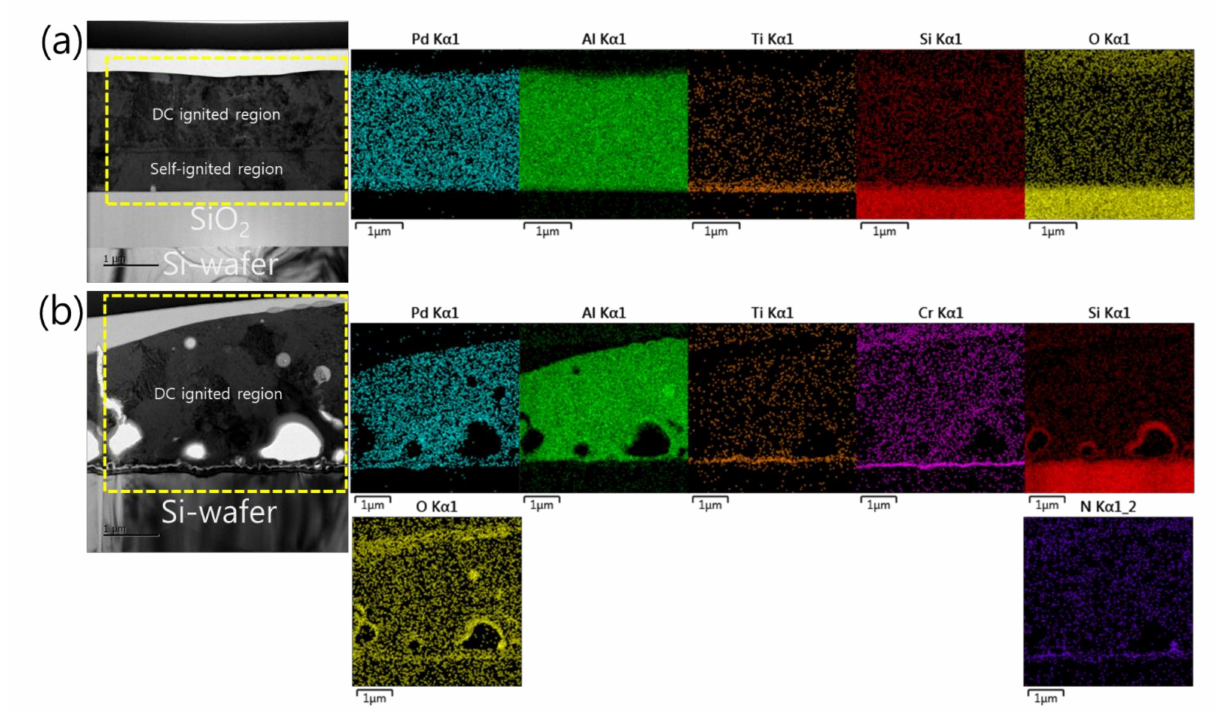
Figure 7. TEM cross sections ( left ) and corresponding EDS elemental mappings ( right ) of the Pd/Al-iRMS reaction product microstructure after the exothermic propagation reaction. ( a ) Pd/Al-iRMS with a bilayer thickness of δ = 100 nm grown on a SiO 2 -coated Si-wafer; ( b ) Pd/Al-iRMS with a bilayer thickness of δ = 200 nm grown on a PdO x -buffered